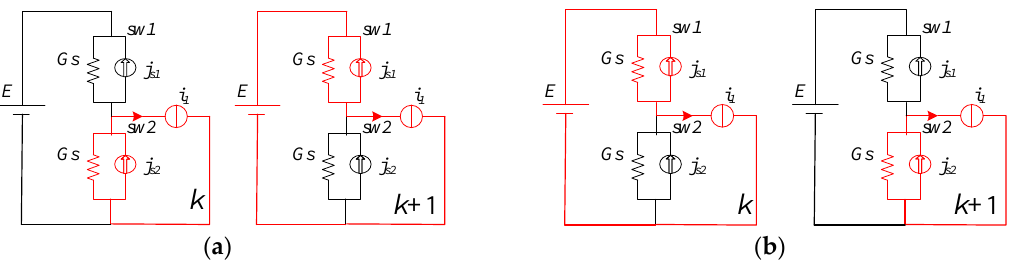
Figure 3. The commutation process of sw1 ( i 1 >0): ( a ) From OFF to ON; ( b ) From ON to OFF.